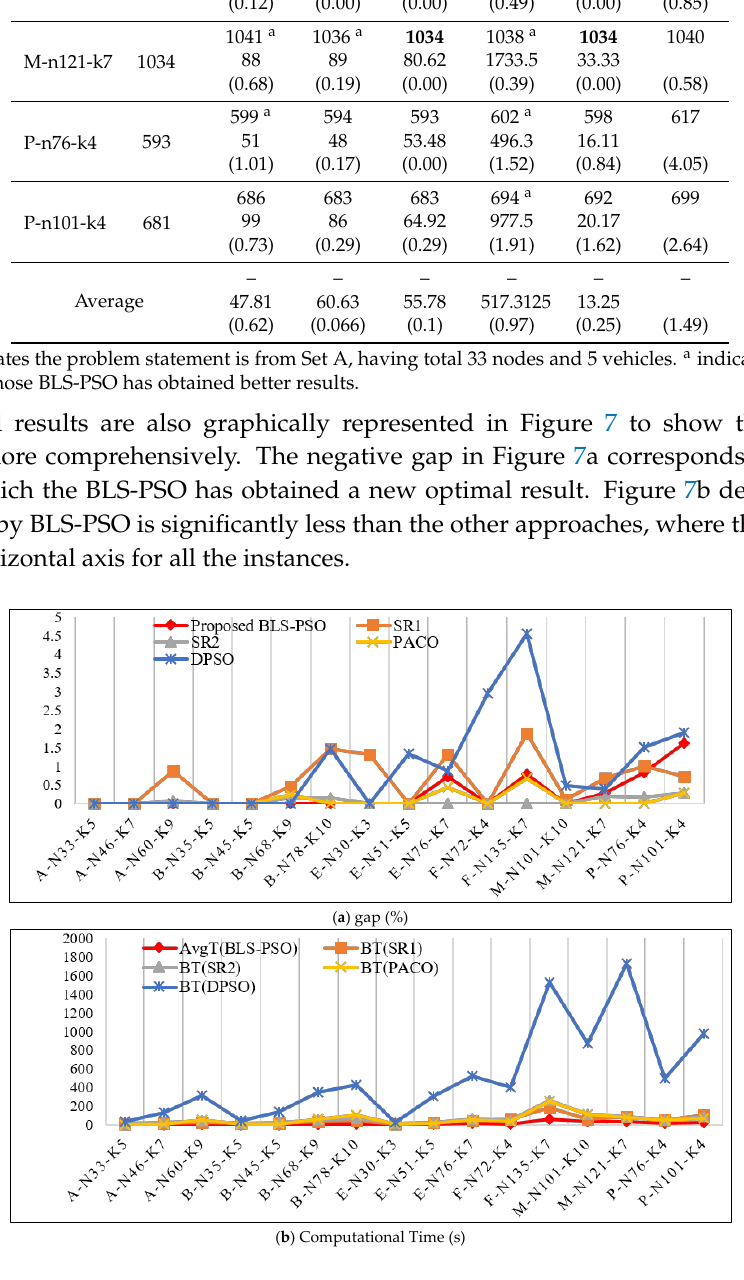
Table 12. Performance comparison of BLS-PSO with respect to other PSO-based approaches for solving the instances of Set CMT.